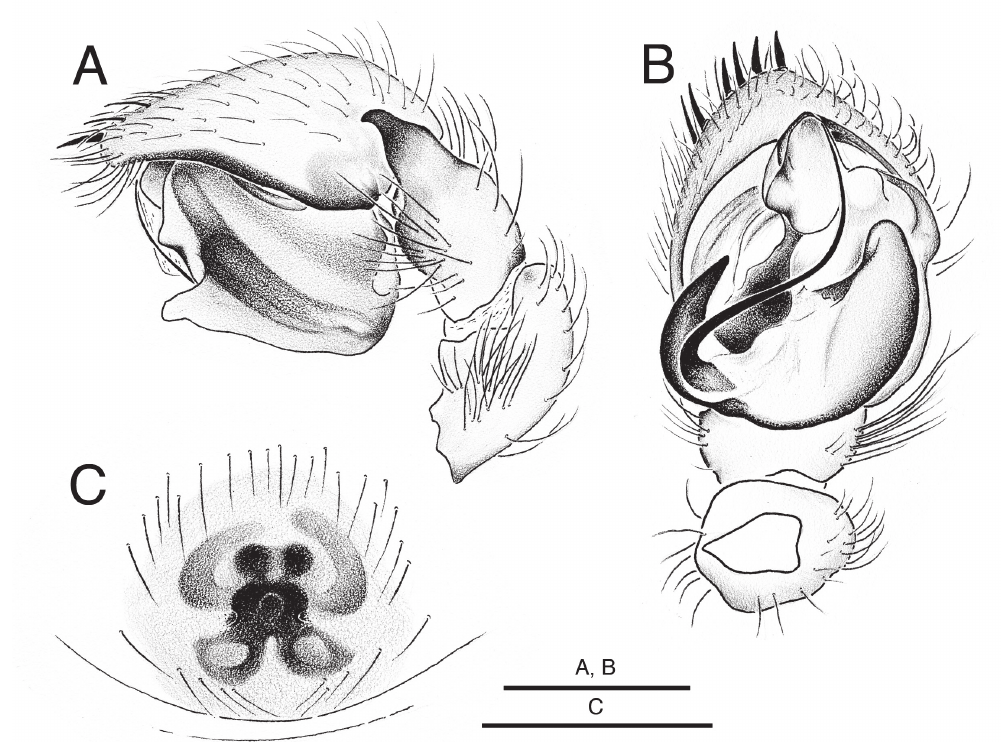
Fig. 7. Ballomma haddadi gen. et sp. nov. A–B . Holotype, ♂. C . ♀ (MRAC 132641). A . Male palp, retrolateral view. B . As preceding, ventral view. C . epigyne, ventral view. Scale bars: 0.5